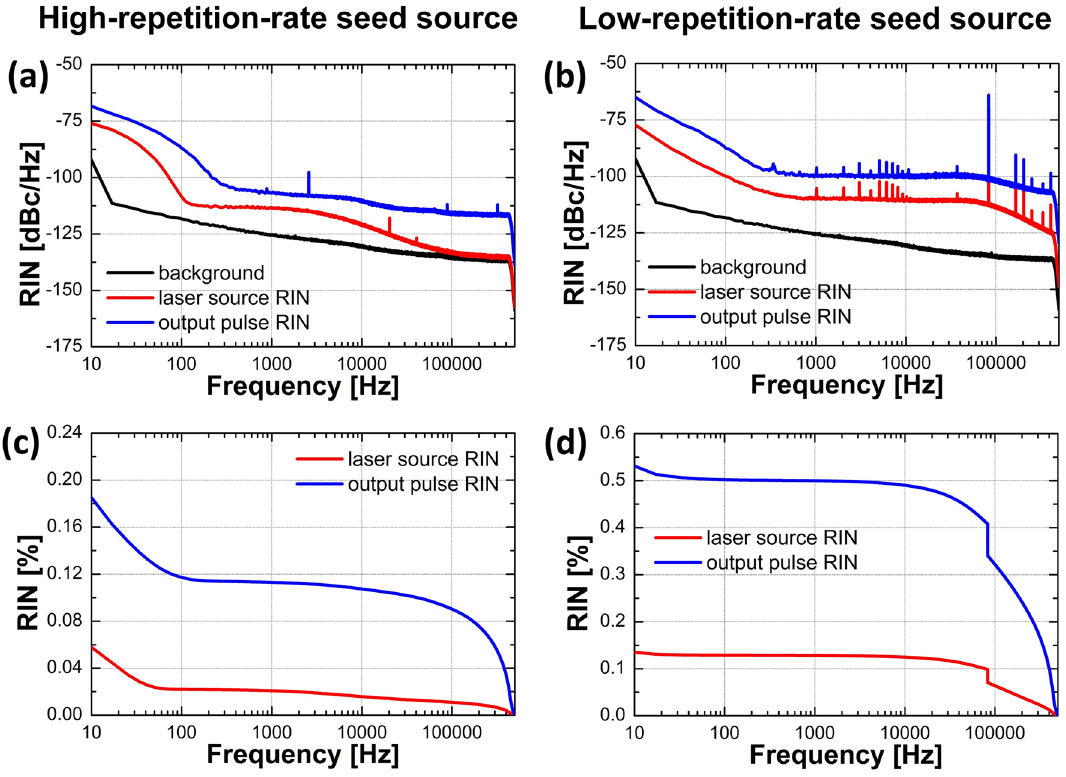
Figure 11. Characterization of the intensity noise of laser sources (red) and also amplified and compressed output pulses (blue): RIN results for ( a ) the high-repetition-rate and ( b ) the low-repetition-rate seed source, together with integrated RIN for ( c ) the high-repetition-rate and ( d ) the low-repetition-rate seed